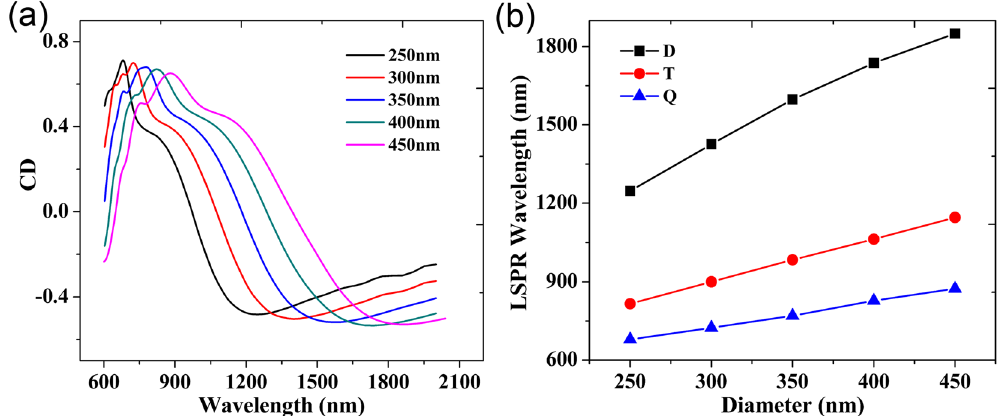
Figure 6. ( a ) Calculated CD spectra of the metal nanocrescents with the diameters over a range of 250–450 nm. ( b ) Dependence of LSPR wavelength of CD spectra on the metal nanocrescent diameter. Here the “D”, “T” and “Q” correspond to dipolar mode, tripolar mode and quadrupolar mode,